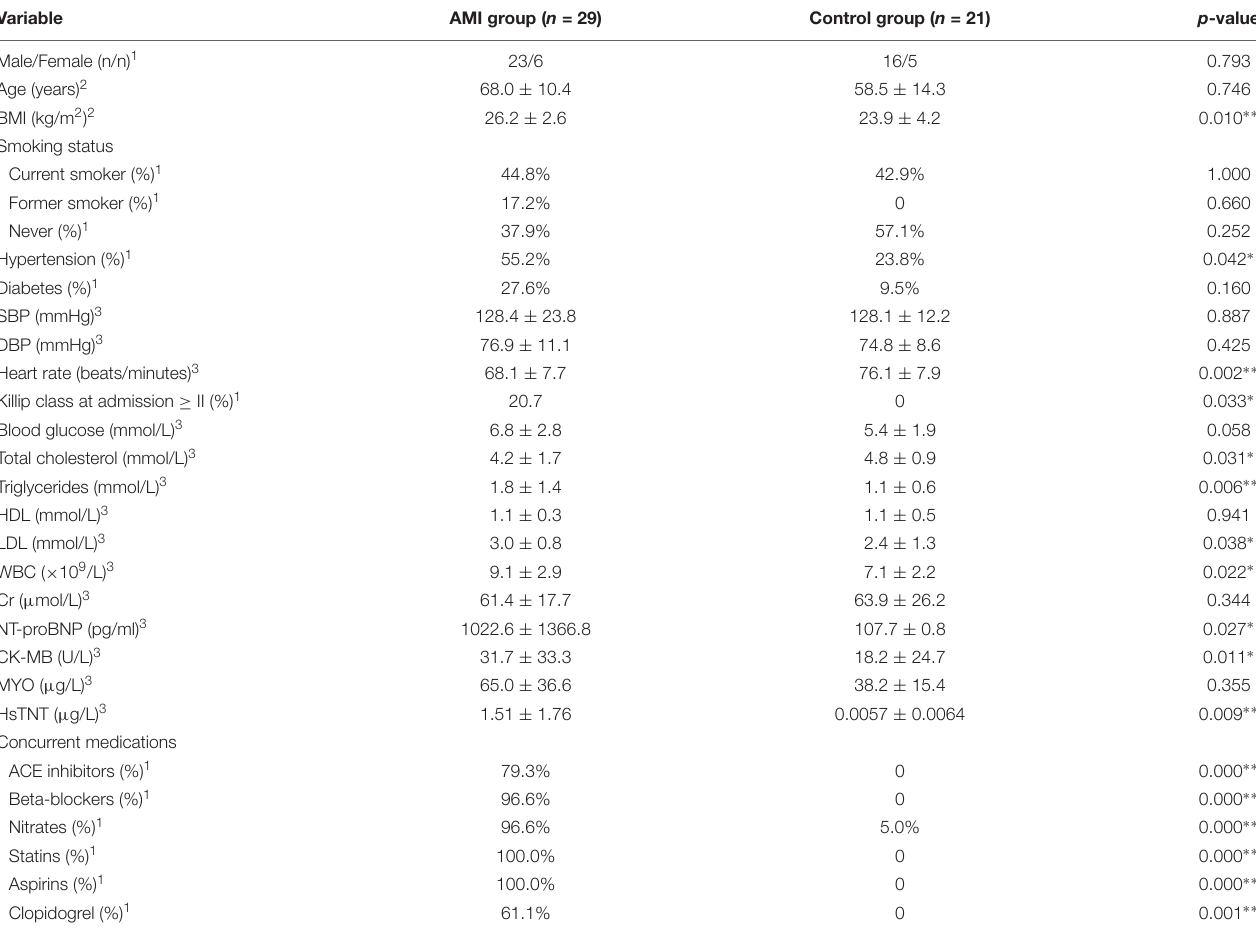
TABLE 1 | Clinical characteristics of AMI patients and the control subjects.